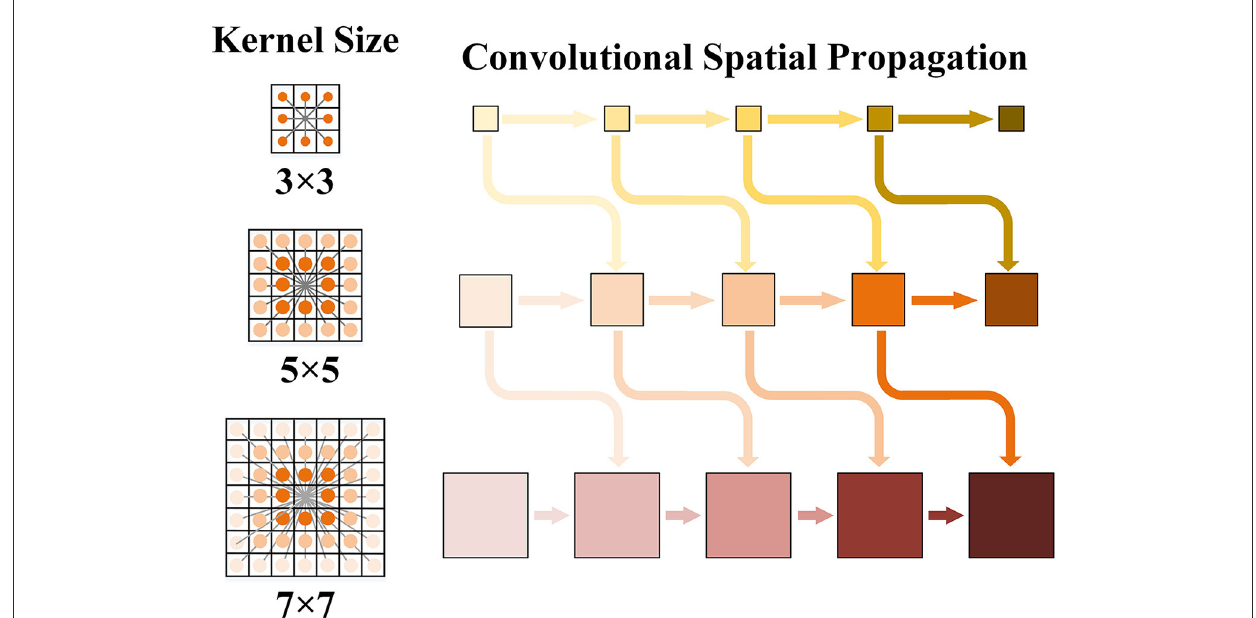
FIGURE4 Schematic diagram of kernel convolution space propagation. Three convolution kernels are taken as examples. The local depth information is enhanced with the horizontal arrows propagating to the right respectively. There is cross-scale connection guidance between cores of different sizes.